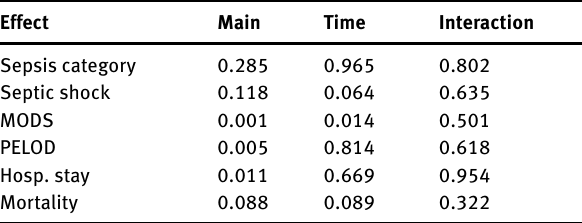
Table 3: Summary of p-values of ANOVA model effects Effect